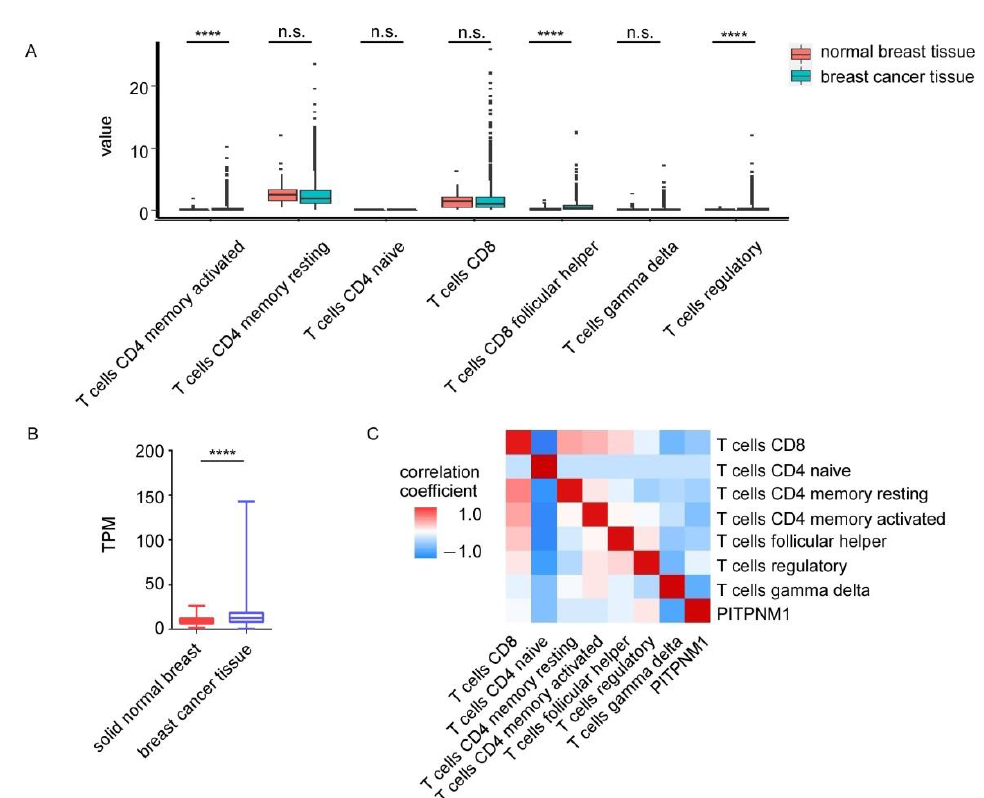
Figure 4. The relationship between PITPNM1 and T cell sub-population abundance. ( A ) The abundance of T cell subtypes in TCGA cohort estimated by CIBERSORTx. t -test; n.s., not significant, p > 0.05; **** p < 0.0001. ( B ) The expression of PITPNM1 in TCGA breast cancer cohort. Normal breast, n = 113; breast cancer tissue, n = 1104. **** p < 0.0001. ( C ) Heatmap of Spearman correlation coefficient between PITPNM1 and T cell subtypes.